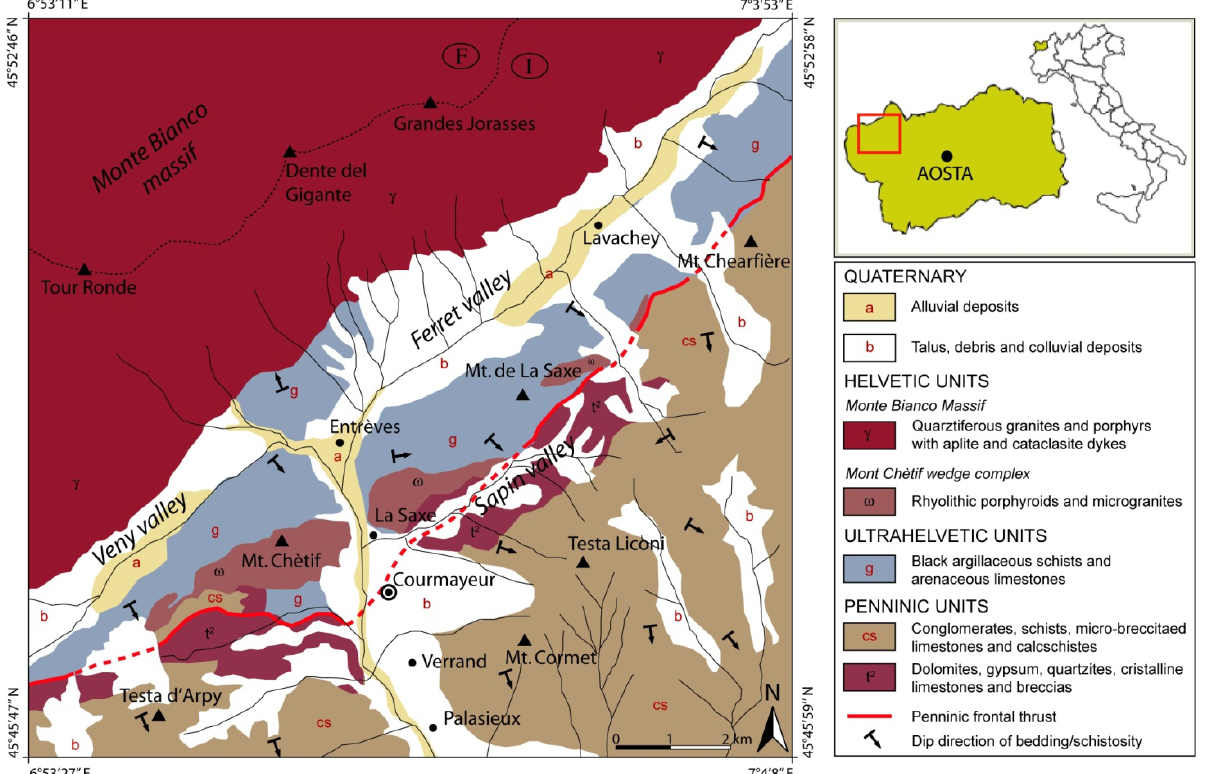
Figure 2. Geologic and structural sketch of the study area. Modified from Carta Geologica d’Italia 1:100,000, Sheets